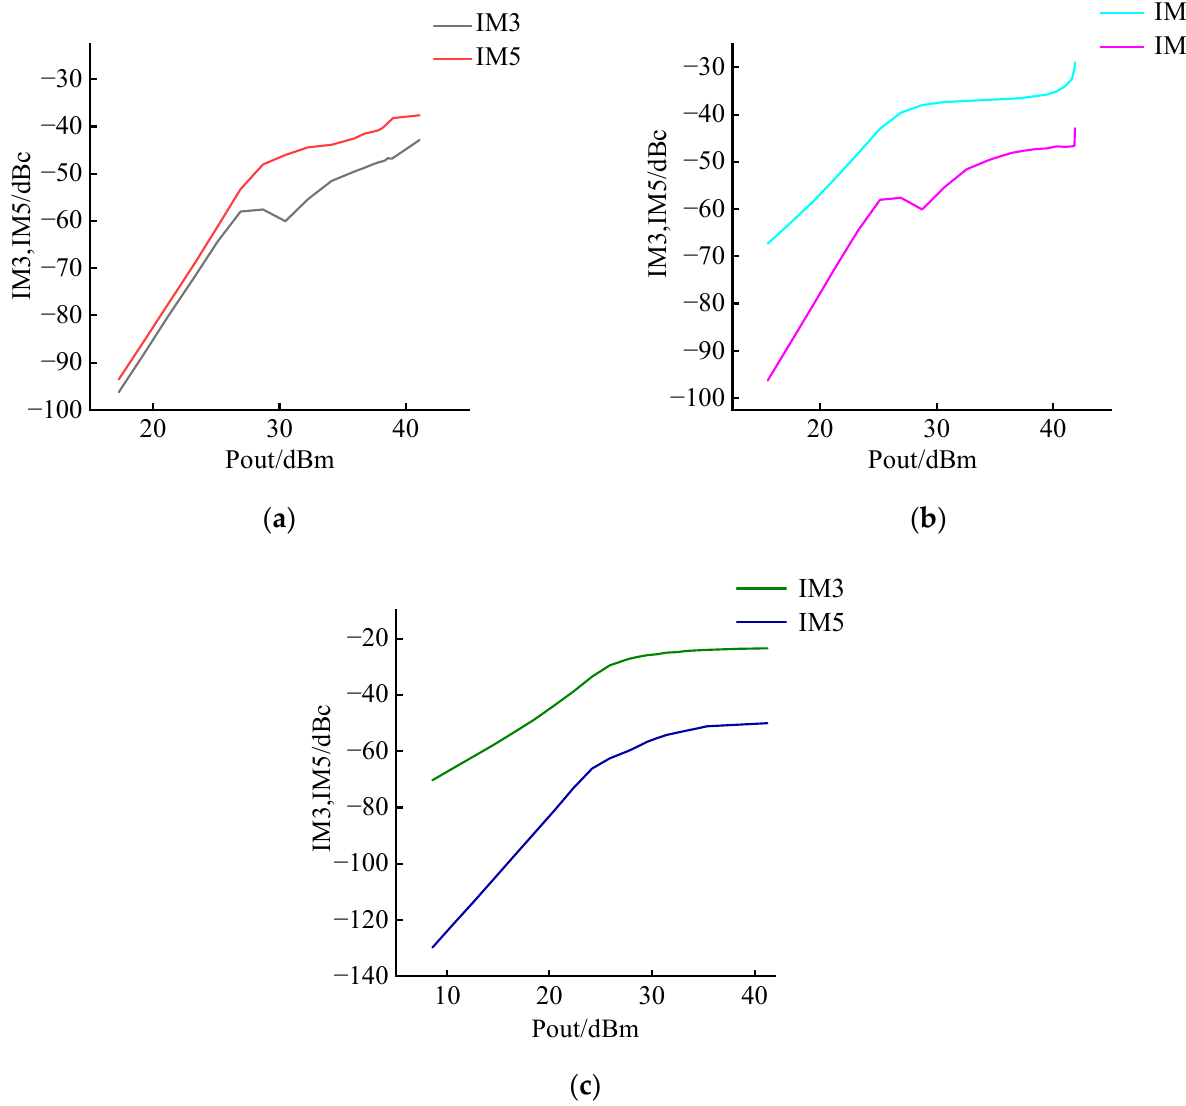
Figure 9. Third-order intermodulation distortion and fifth-order intermodulation distortion test re- sults. ( a ) at 2.2 GHz simulation results. ( b ) at 2.6 GHz simulation results. ( c ) at 3.5 GHz simulation results.